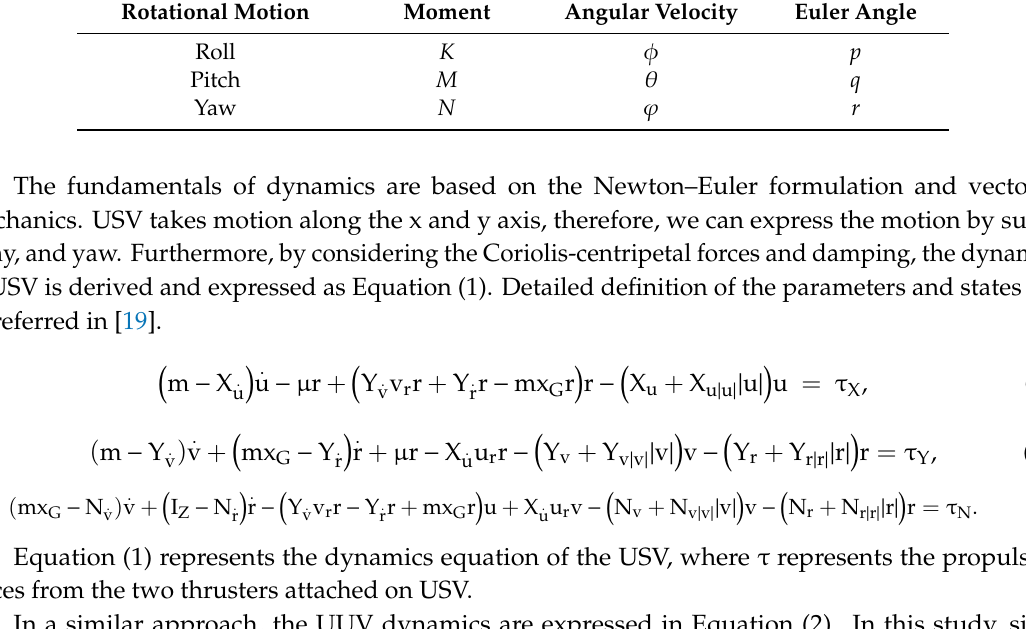
Table 1. The notation of SNAME for unmanned surface vehicle (USV) and unmanned underwater vehicle (UUV). Translational Motion Force Linear Velocity Position Surge X x u Sway Rotational Motion Moment Angular Velocity Euler